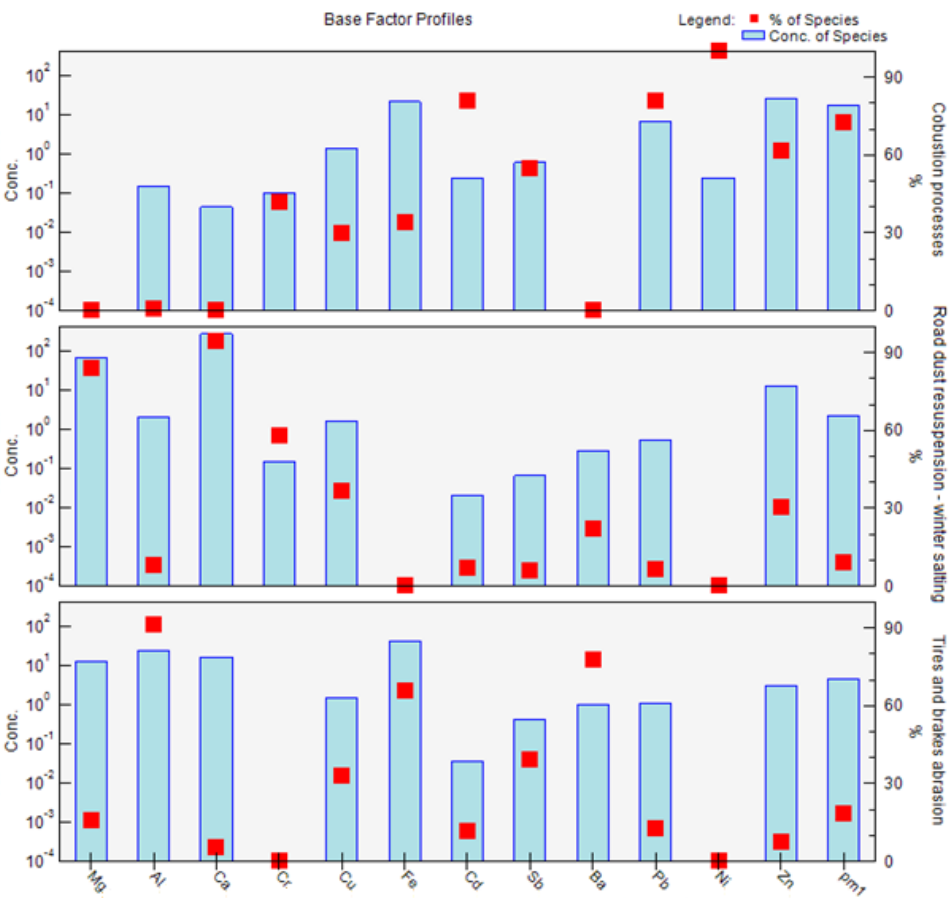
Figure 8. Factor profiles: division of elements into individual factors, and their characterization, from measurements of PM 1 taken in the city of Žilina.